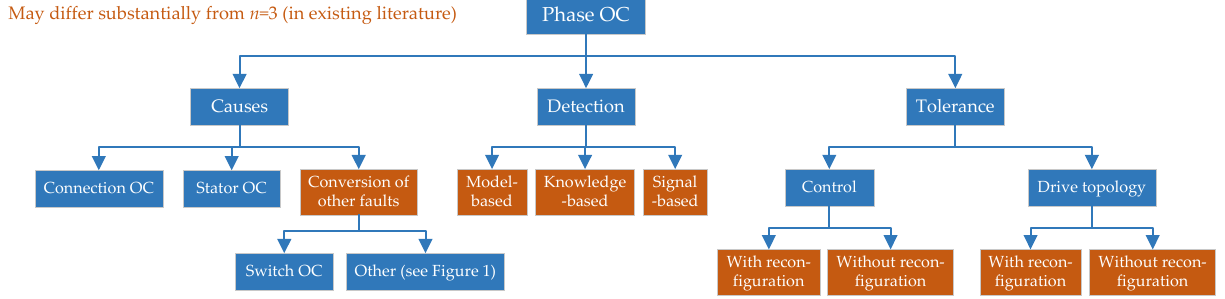
Figure 2. Causes, detection methods, and tolerance approaches for phase OC faults (or similar) in multiphase drives. Table 1. General classification of references about tolerance to phase/switch OCs in multiphase drives. Survey papers and books are not included in this